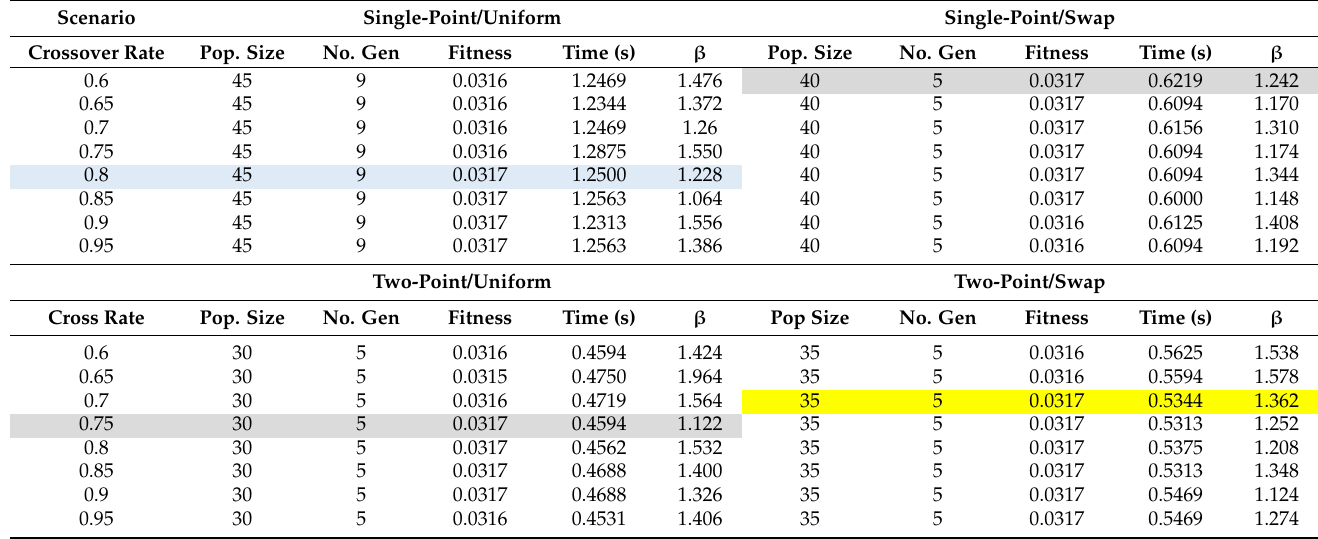
Table 3. The impact of crossover rate on the GA accuracy. The best results are highlighted.